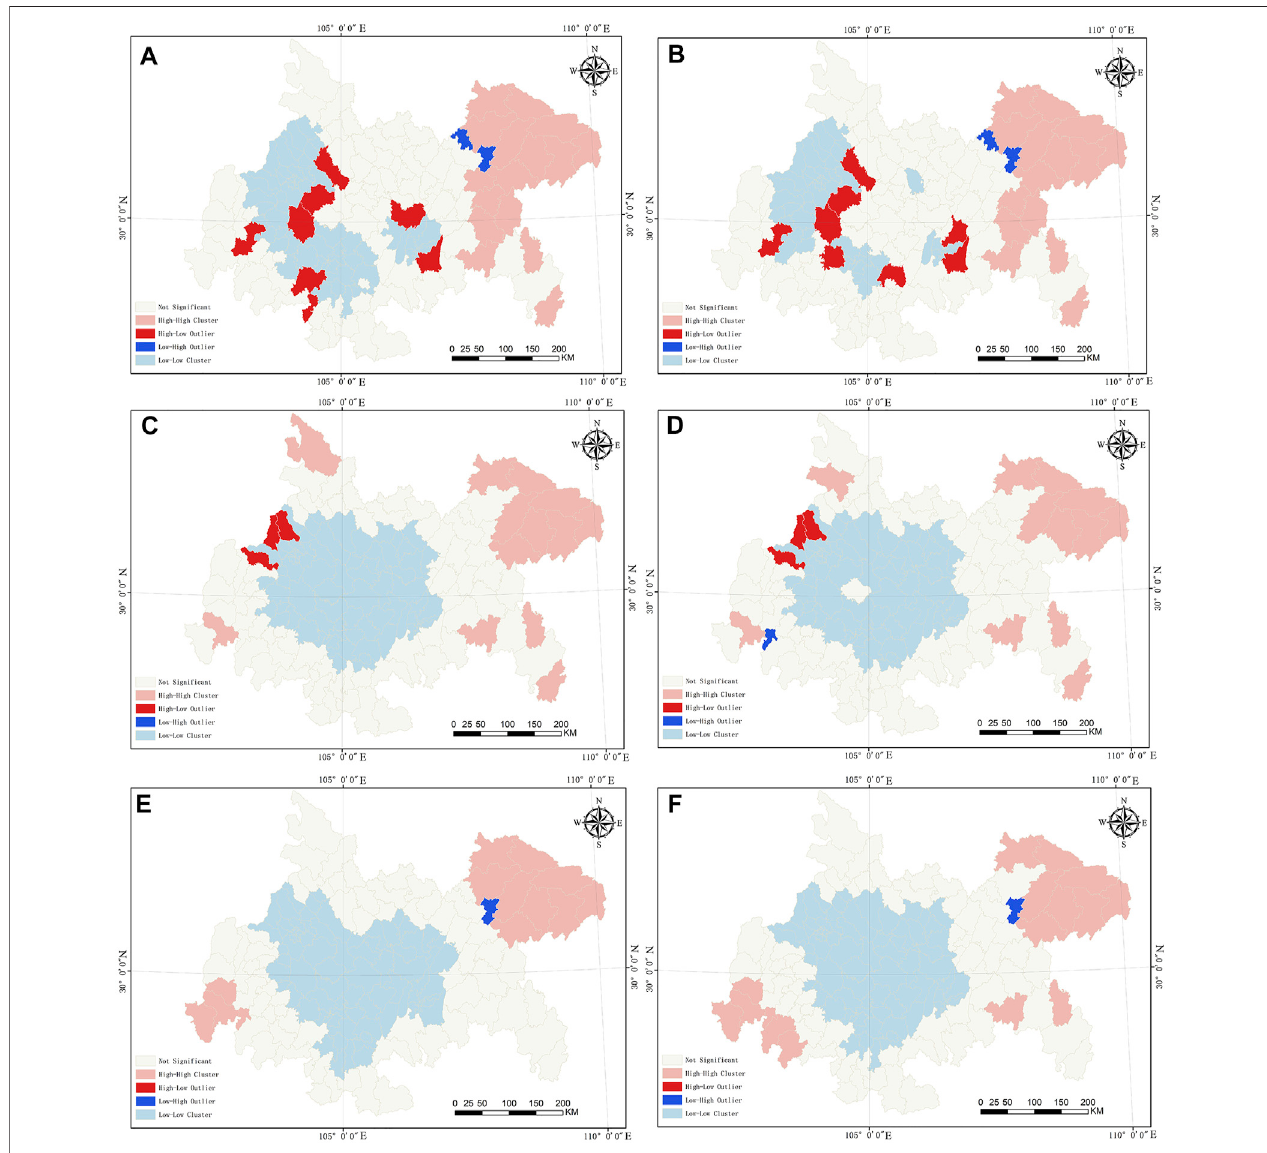
FIGURE 3 | LISA agglomeration distribution of ES from 2000 to 2015 (A) 2000 annual WY; (B) 2015 annual WY; (C) 2000 annual CS; (D) 2015 annual CS; (E) 2000 annual SC; and (F) 2015 annual SC.